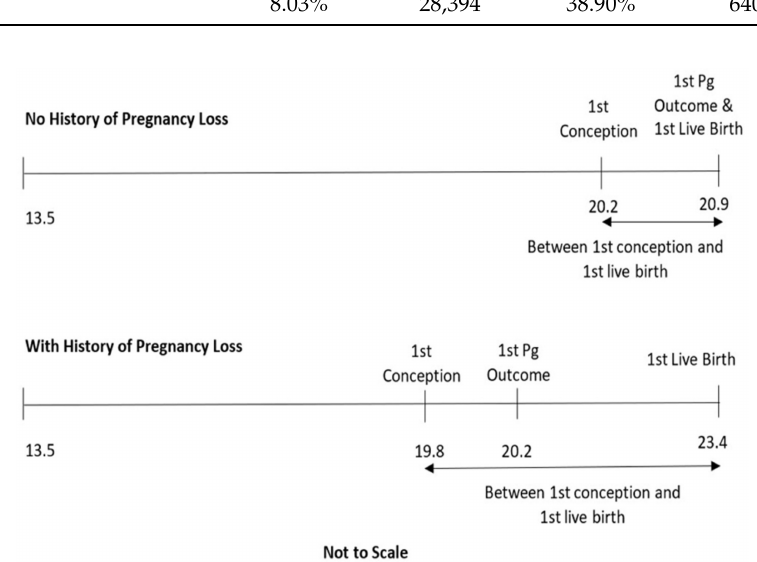
Figure 1. Mean average age of women at entry into cohort, first conception, first pregnancy (Pg) outcome, and first live birth, segregated by any history of pregnancy loss. Not to